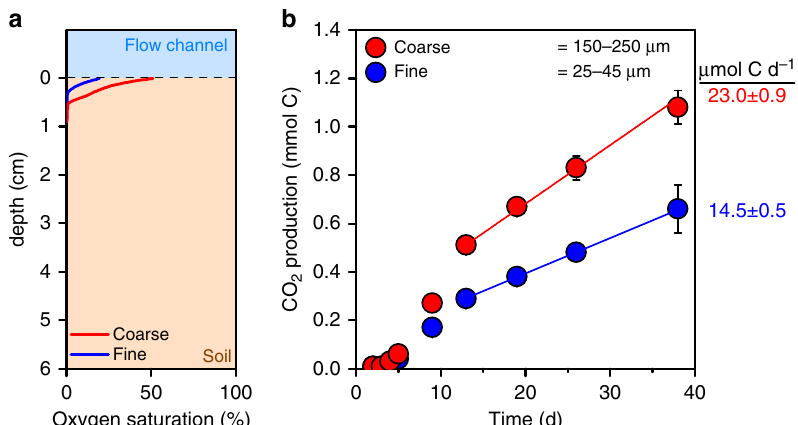
Fig. 1 Microsite impacts on metabolic rates in fl ow reactor experiments. a Particle size-induced variations in the anaerobic pore volume. Oxygen pro fi les in reactor experiments conducted with soil amended with quartz grains of different particle sizes (coarse = 150 – 250 µ m and fi ne = 25 – 45 µ m). Oxygen pro fi les are the average of three replicate pro fi les recorded with microelectrodes on day 35 of the incubation. b Particle size-induced variations in CO 2 production (i.e., mineralization) over the incubation period. Linear fi ts indicate the incubation period used to calculate mineralization rates. Error bars denote the standard error of the mean calculated from four replicate